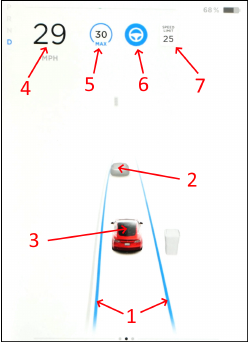
Figure 7. Tesla HMI design and corresponding icon number.